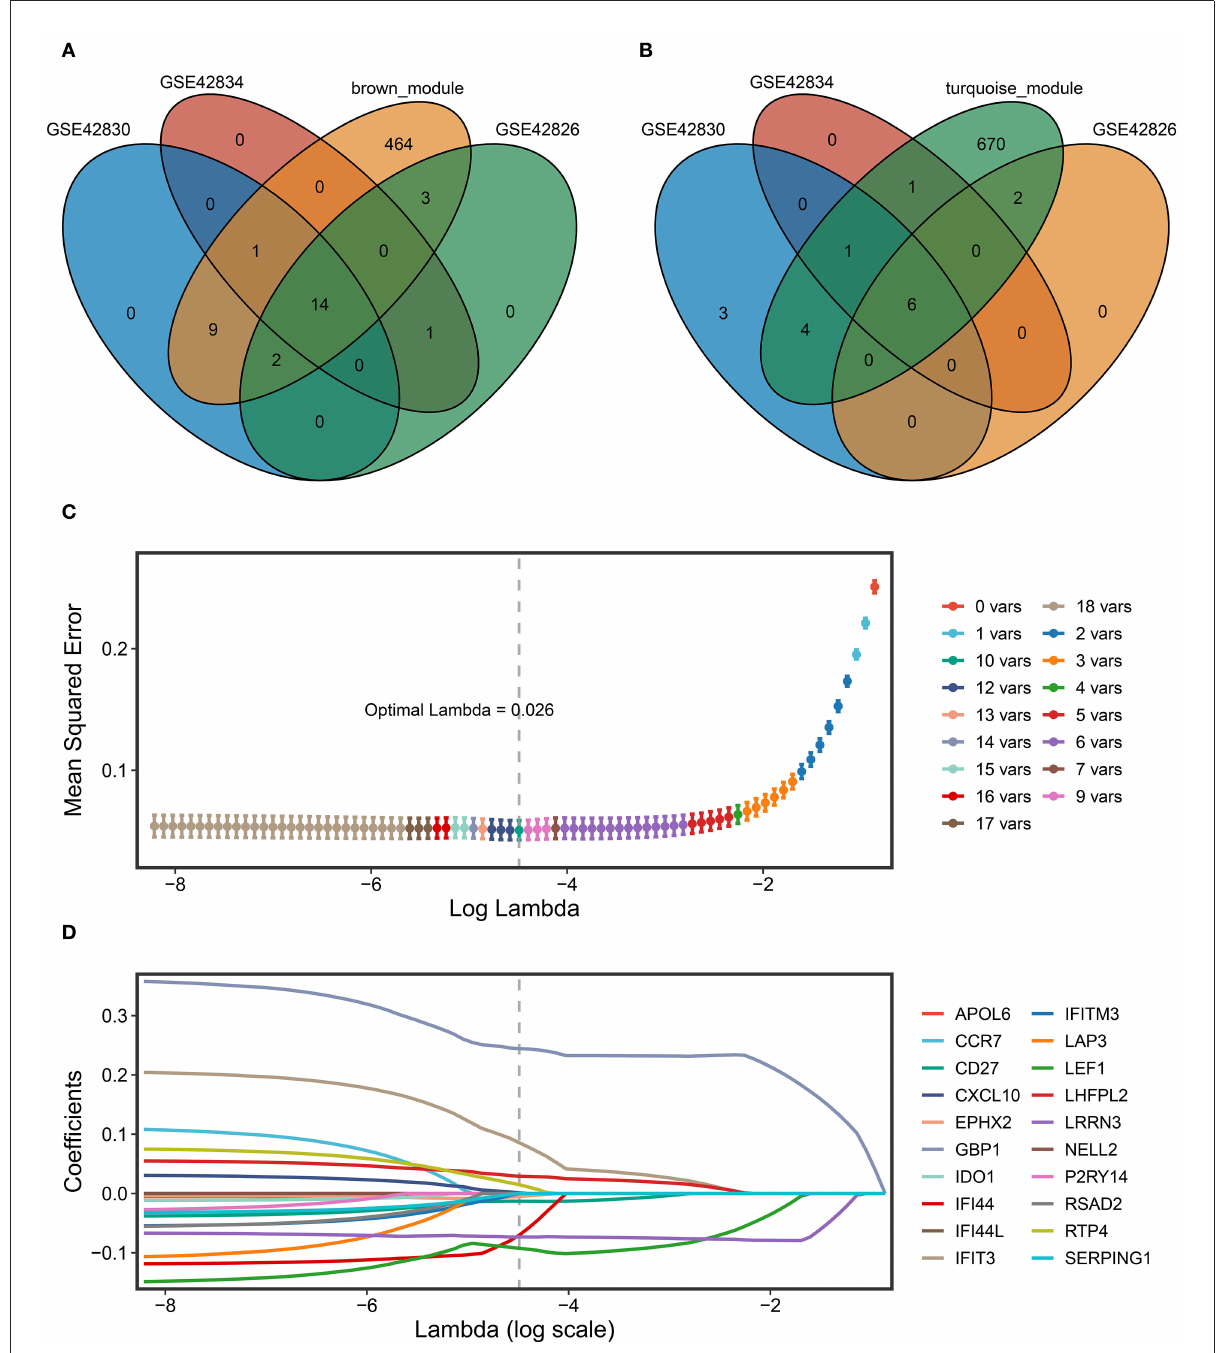
FIGURE5 The construction of the SARDS based on the LASSO algorithm. (A) The Venn diagram of the intersection between the upregulated DEGs in three datasets and genes in the brown module. (B) The Venn diagram of the intersection between the downregulated DEGs in three datasets and genes in the turquoise module. (C) Determination of the optimal lambda was obtained when the partial likelihood deviance reached the minimum value, and further generated the key gene with nonzero coefficients. (D) LASSO coefficient profiles of the candidate gene for SARDS